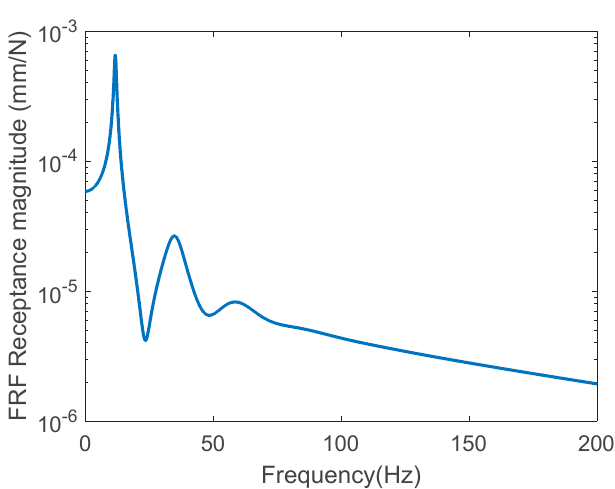
Figure 4. FRF receptance magnitude curve of a noise-free state. Table 1. Summary of the impact hammer test on a both-end-fixed beam.